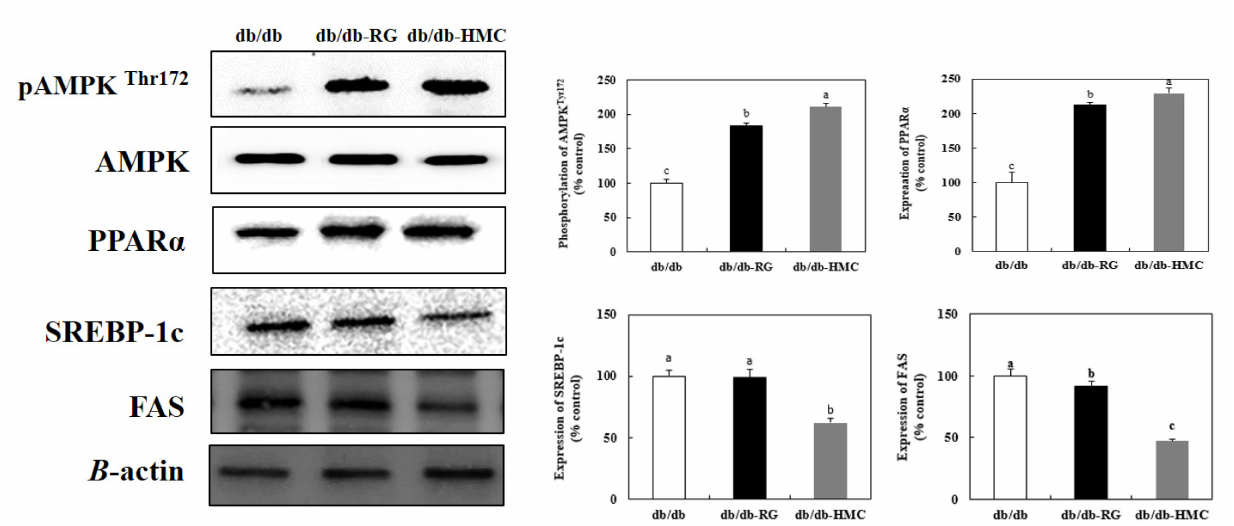
Figure 7. The effects of HMC administration on pAMPK Thr172 , SREBP-1c, FAS and PPAR α expression in liver of C57BL/KsJ db/db mice. Mean ± SD ( n = 8). a–c The mean values that are not indicated by a common letter are significantly different among the groups ( p < 0.05) according to Duncan’s multiple range test. SD, standard deviation. db/db, db/db-RG (5 mg/kg BW per day) and db/db-HMC groups (30 mg/kg BW per